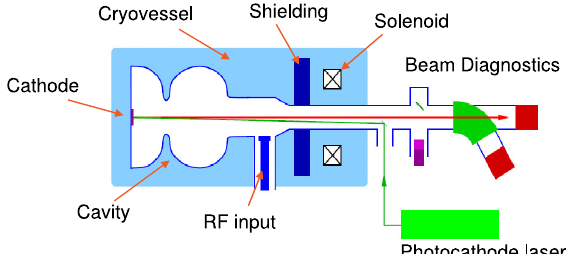
FIG. 9. Generic design of the 1.3 GHz 1.6 cell BERLinPro SRF gun. Courtesy of Thorsten Kamps, HZB.